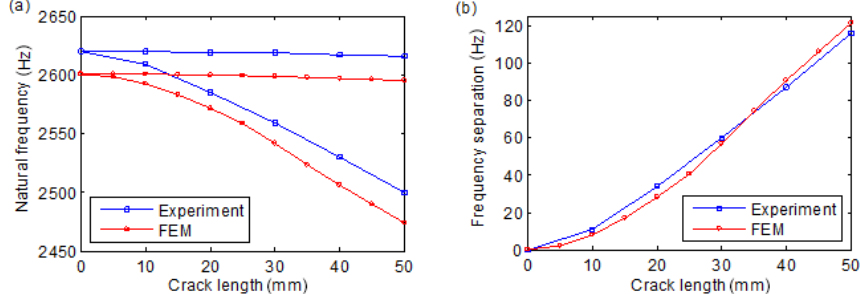
Figure 14. Evolutions of the (a) shift and (b) separation of the 2ND natural frequencies versus crack